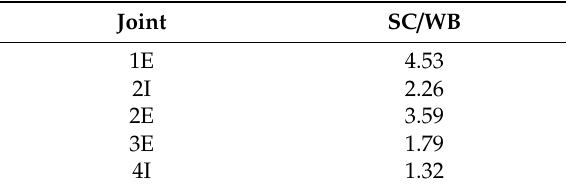
Table 1. Strong-column / Weak-beam Moment Ratio in joints